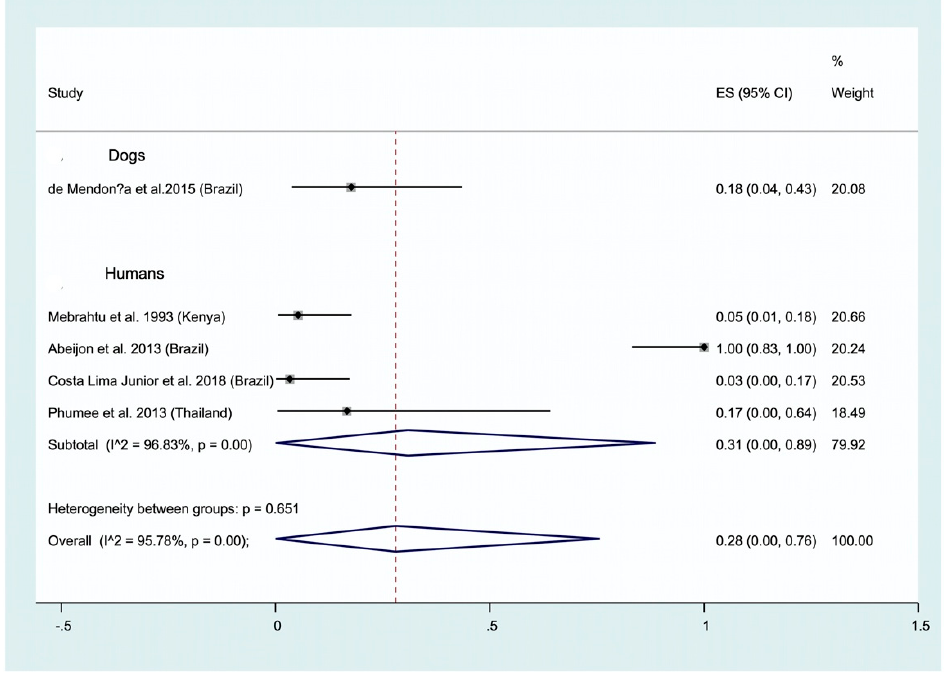
Figure 5. Forest plot representation of the extracted data for urine analysis using parasitological methods on leishmaniasis with subgroup analysis on dogs and humans. Human African Trypanosomiasis and Animal Trypanosomiases. Analysis cannot be performed due to a lack of quantitative data.